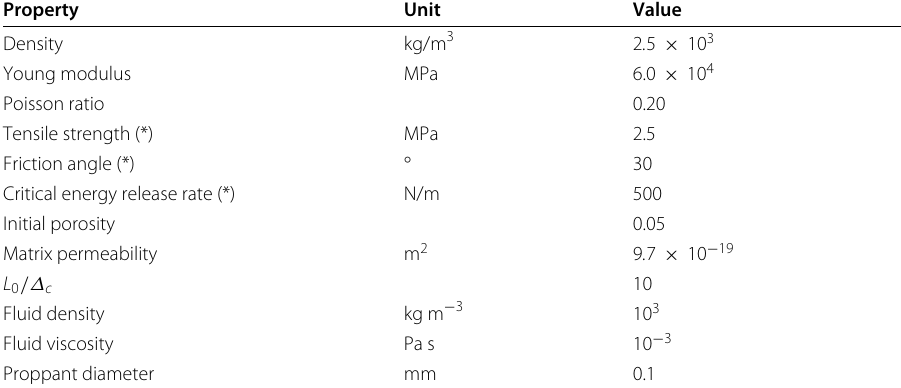
Fig. 12 Large scale reservoir analysis. a Distribution of the magnitude of the opening displacement on the faults. Maximum opening 0.5 mm (red color). b Time evolution of the fracture surface (black circles) and fracture volume (grey circles) Table4 Sequential hydraulic fracturing of large scale